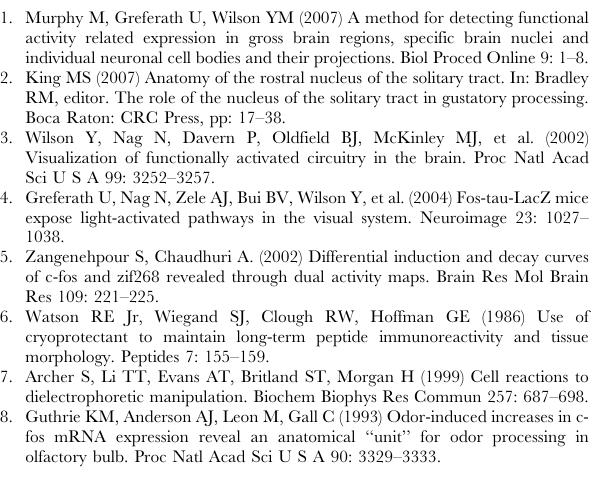
Figure S38 High background Fos-LI staining is present in the nTS of FTL, but not WT, mice stimulated with MSG. Photomicrographs of Fos-LI in the Rostral level of the nTS of a wild type (WT; Left ) and FTL ( Right ) mouse. Both animals were stimulated with 150 mM MSG in the exact same way and brain tissue from each animal was processed for Fos-LI using the same reagents. Images converted to greyscale colors for clarity. Background staining is defined as ‘non-specific immunofluores- cence that was not localized to cell nuclei.’ Figure S39 b – galactosidase staining is similar across all experimental conditions even when normalized to nTS size. The percent of nTS labeled with b -gal (calculated